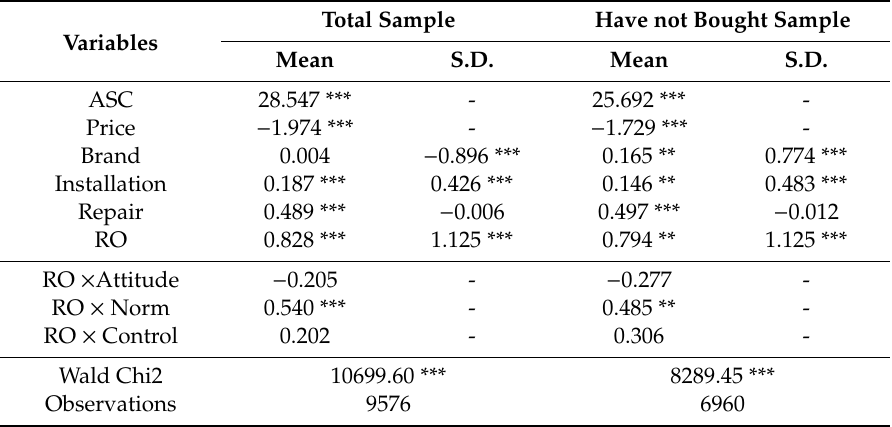
Table 7. The results of risk perception e ff ects on the defensive attribute preference.